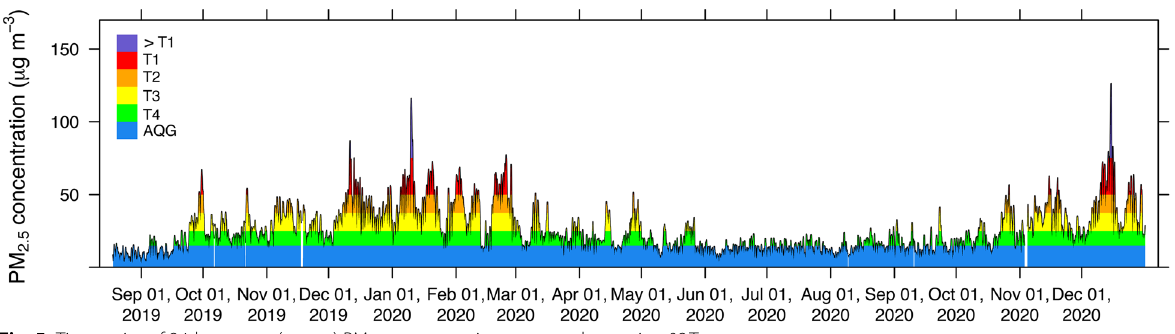
Fig. 5 Time series of 24-h average (center) PM 2.5 concentration measured at station 02